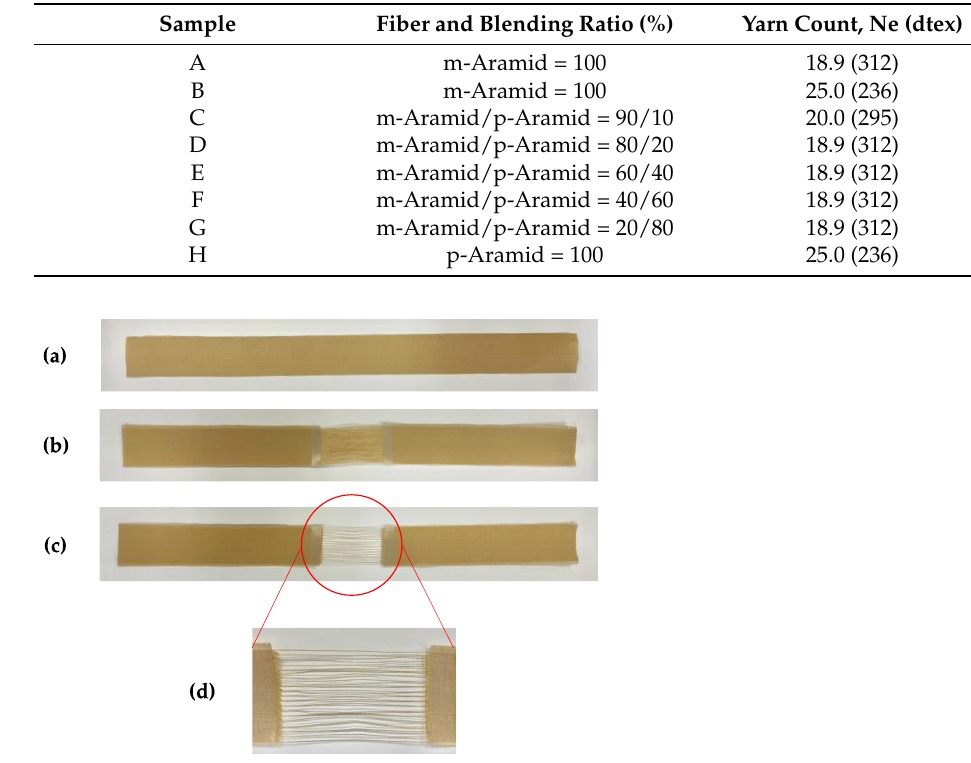
Table 1. Specification of the test yarn.